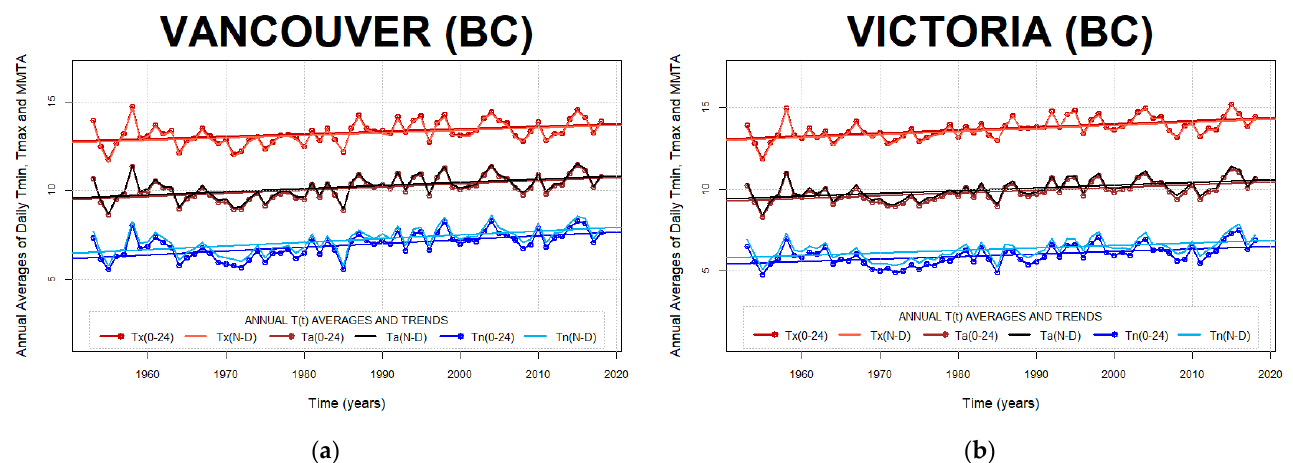
Figure A7. Pacific Coast climate region. Effect of the observing window on long-term air temperature averaging at Vancouver ( a ) and Victoria ( b ) stations. Annually averaged diurnal air temperature minima, maxima, and Min-Max averages obtained with COW 0–24 and COW N–D air temperature approximating methods.